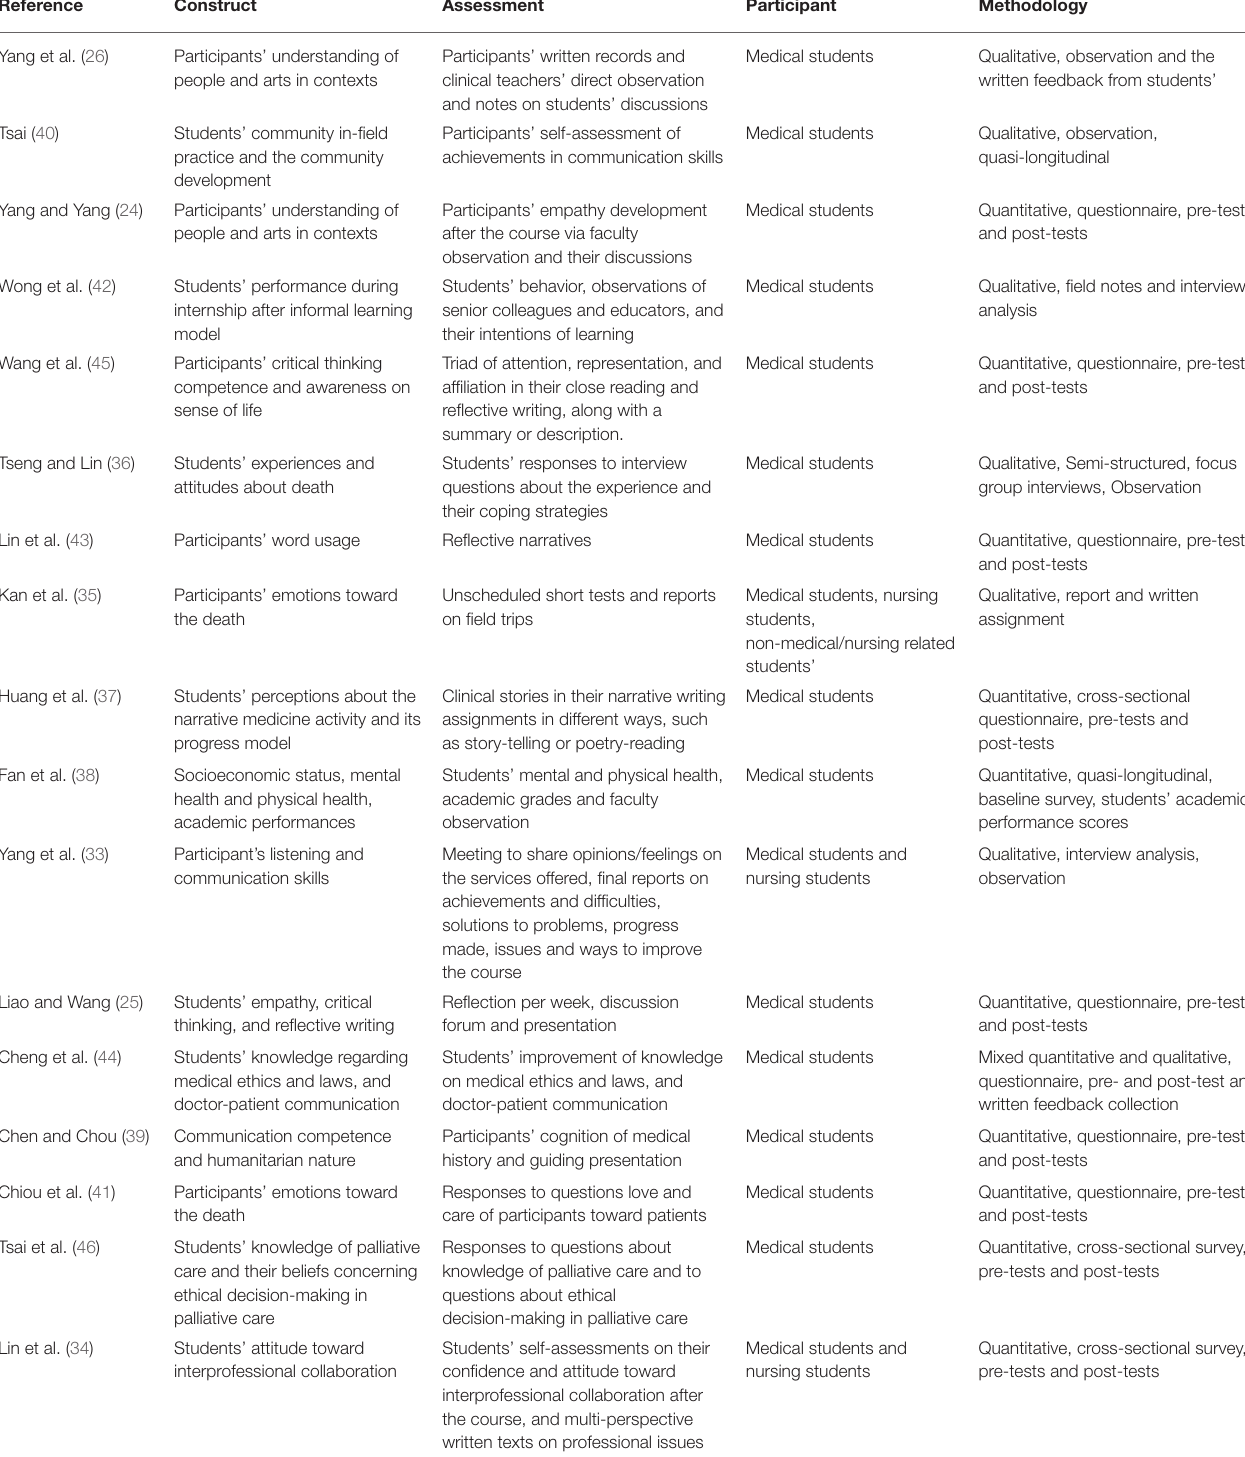
TABLE 2 | Extraction of constructs and assessments in Taiwan medical curricula, research methodologies used and participants of Taiwan’s medical humanities articles.